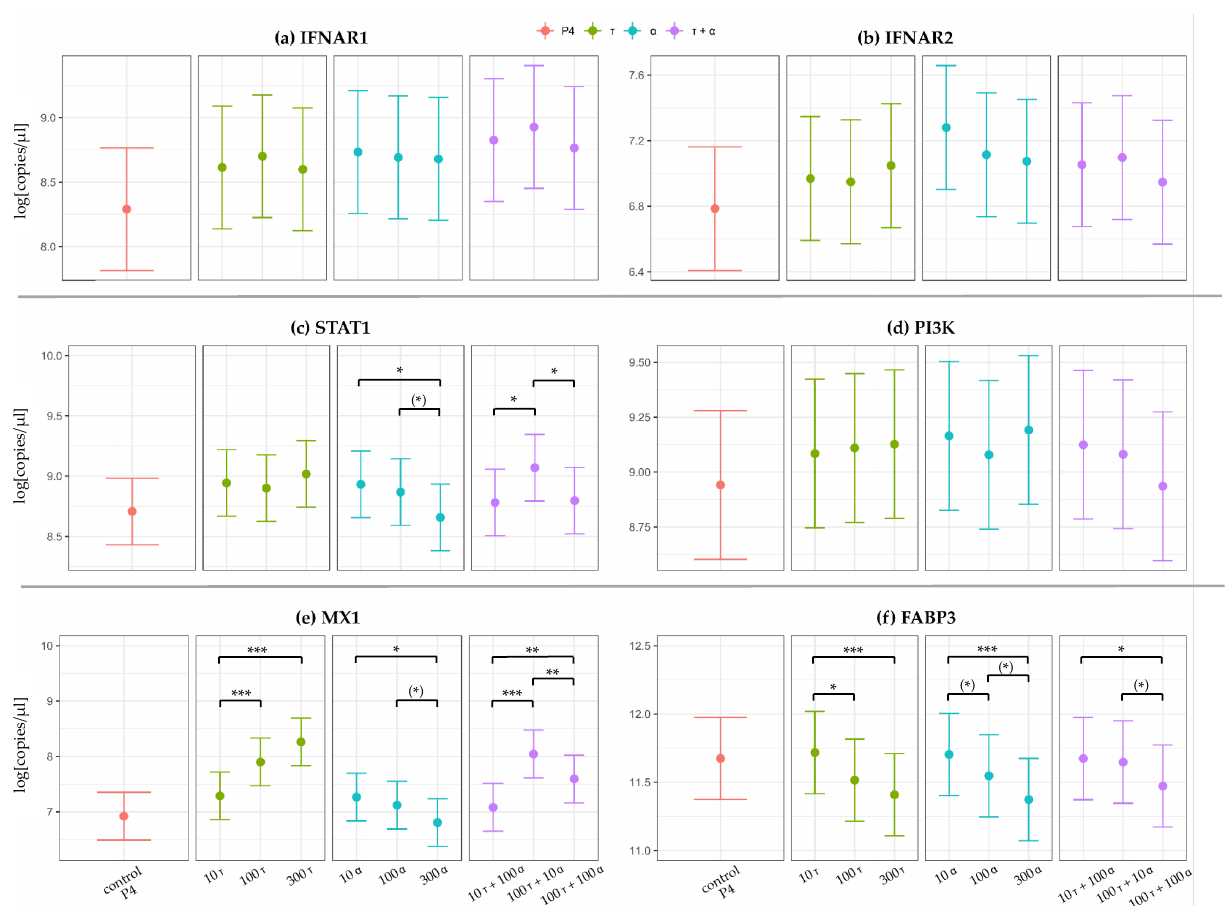
Figure 2. Illustration of the log-transformed gene expression of ( a ) type 1 interferon receptor subunit 1 (IFNAR1), ( b ) type 1 interferon receptor subunit 2 (IFNAR2), ( c ) signal transducer and activator of transcription 1 (STAT1), ( d ) phosphoinositide 3-kinase (PI3K), ( e ) interferon-induced GTP-binding protein (MX1), and ( f ) fatty acid-binding protein (FABP3) measured in bovine endometrial explants via a quantitative real-time polymerase chain reaction (RT-qPCR). X-axis: explants were treated with 20 ng/mL progesterone (control P4, displayed in red) or with 20 ng/mL P4 and interferon τ ( τ ) and/or interferon α ( α ) at different concentrations (10, 100 and 300 ng/mL τ or α ) and in different combinations (10 τ + 100 α , 100 τ + 10 α and 100 τ + 100 α ). The Y-axis represents log-transformed data of linear mixed effect models (natural logarithm). Significance codes: statistical tendencies p < 0.1 are marked with (*), statistical significances at p < 0.05, p < 0.01, and p < 0.001 are marked with *, **, and ***, respectively. Only significant differences within the three subsets τ (displayed in green), α (displayed in blue), and τ + α (displayed in purple) are marked with asterisks. Significant differences between the treatment group sets or between treatment groups and the control P4 are not marked in this graph, but can be found in Table